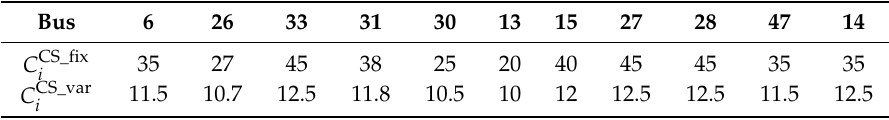
Table 2. Unit fixed and variable investment for candidate CS ( × 10 4 USD).